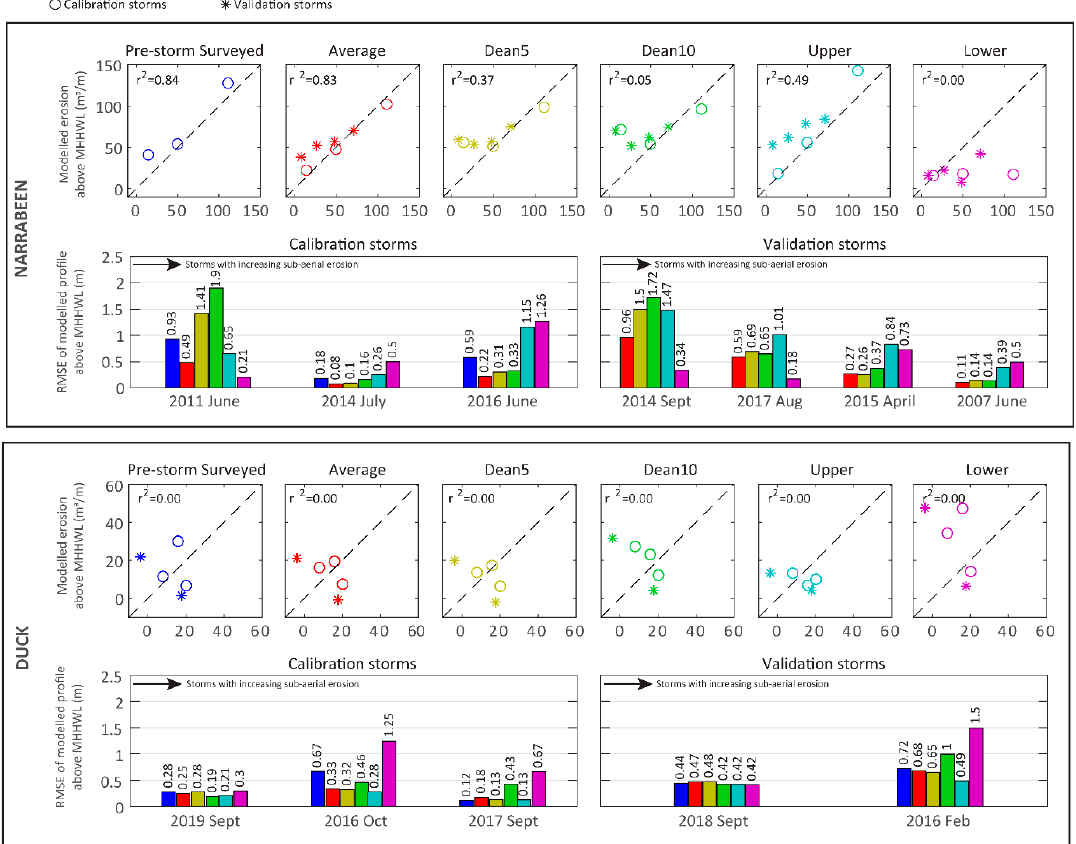
Figure 7. Comparisons of predicted and observed sub-aerial beach erosion volumes and RMSE of modelled profiles, for each of the six assumed nearshore and surf bathymetries. Note that XBeach model calibration was undertaken specific to each of these six bathymetries. In this figure, the RMSE results are arranged from left to right by increasing sub-aerial erosion. The r-squared value for sub-aerial erosion was calculated by adopting the line of best fit without the requirement of a y = 0 intercept. Additionally, note that there are no validation storms for the Pre-Storm Surveyed bathymetry at Narrabeen due to the more limited availability of immediately pre-storm data at this site (refer Table